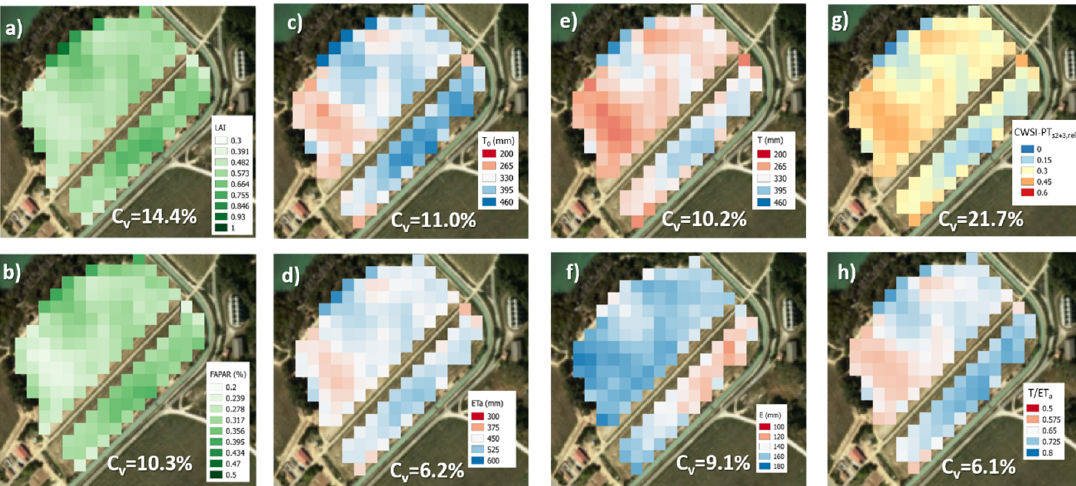
Figure 8. Seasonal maps of the vineyard illustrating the spatial variability in the average ( a ) leaf area index (LAI) and ( b ) fraction of absorbed photosynthetically active radiation (FAPAR), and accumulated ( c ) potential transpiration (T 0 ), ( d ) actual evapotranspiration (ET a ), ( e ) actual transpiration (T), ( f ) soil evaporation (E), ( g ) relative crop water stress index (CWSI-PT S2 + 3, rel ), obtained as 1-T / T 0 with Sentinel data, and ( h ) T / ET a ratio. C v represents the coe ffi cient of variation.